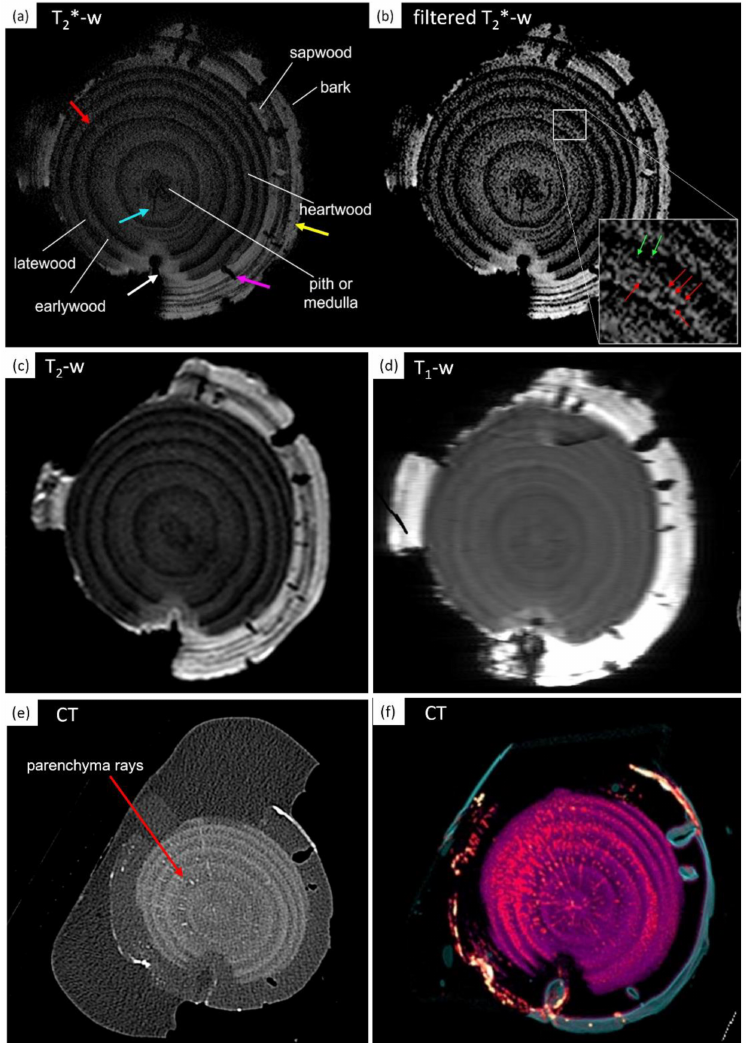
Figure 9. The transversal section of the archaeological wood sample: ( a , b ) T 2 *-weighted MR images; ( c ) T 2 -weighted MR images; ( d ) T 1 -weighted MR images; ( e , f ) CT images. In ( a ) some structural components such as the annual ring limit (red arrow), cavities (yellow arrow), a crack (light-blue arrow), a decayed zone (white arrow), and fractures (pink arrow) are visible. In ( b ) the filter enhances the difference in contrast to the anatomical elements, such as vessels (red and green arrows). In ( e , f ) the CT image highlights parenchyma rays not visible in MR images. Conversely, sapwood structures are only highlighted in NMR images ( a – d ). The archeological wood sample is characterized by a diameter of 8.7 cm and it is 12 cm